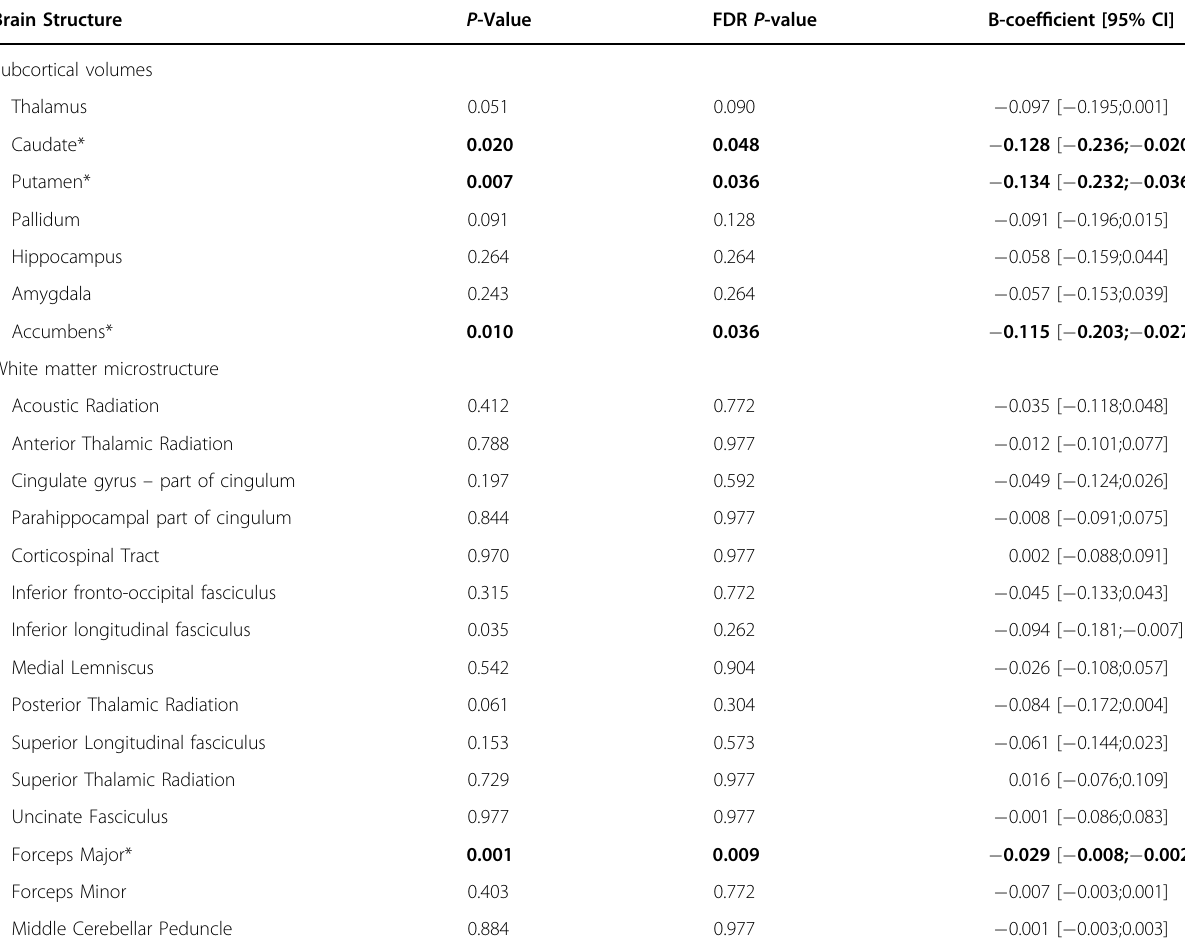
Table 4 The association between “ visions ” ( N = 417) and (1) subcortical volumes and (2) fractional anisotropy values of white matter